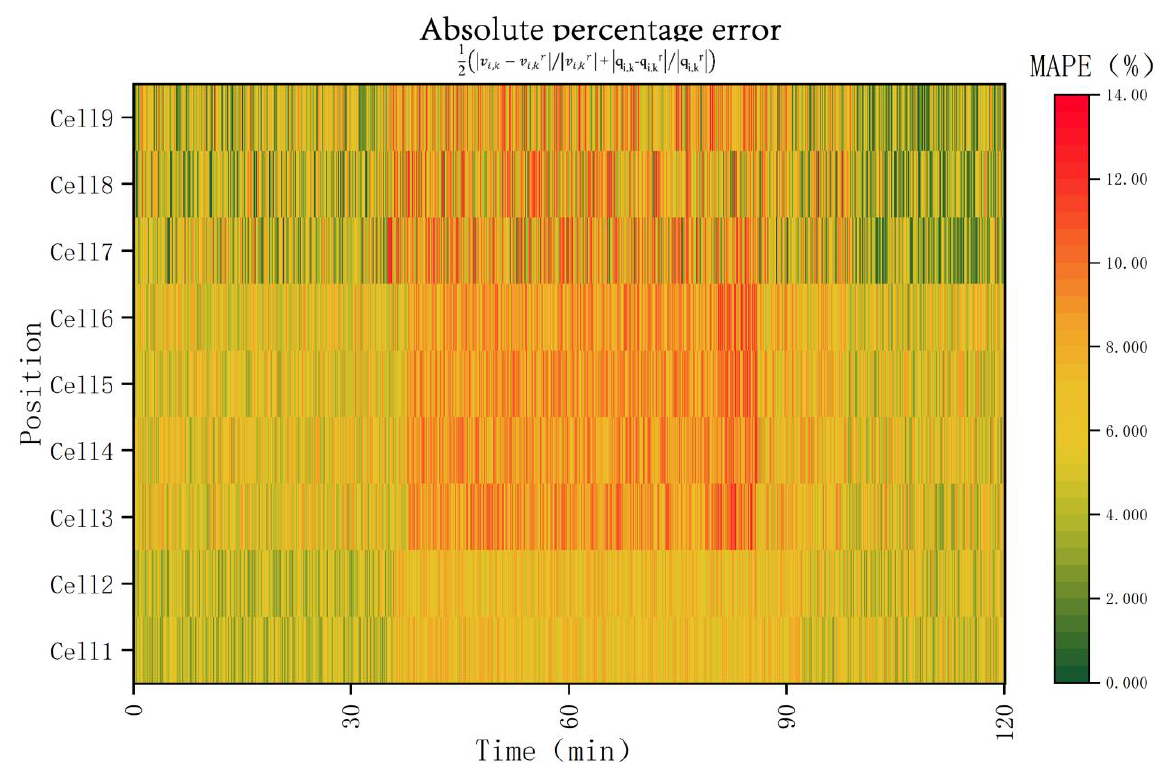
Figure 16. Speed-flow average absolute percentage error distribution. For the control algorithm in the cooperative control strategy, the parameter calibration results are shown in Table 5. Table 5. Control model parameter calibration results.